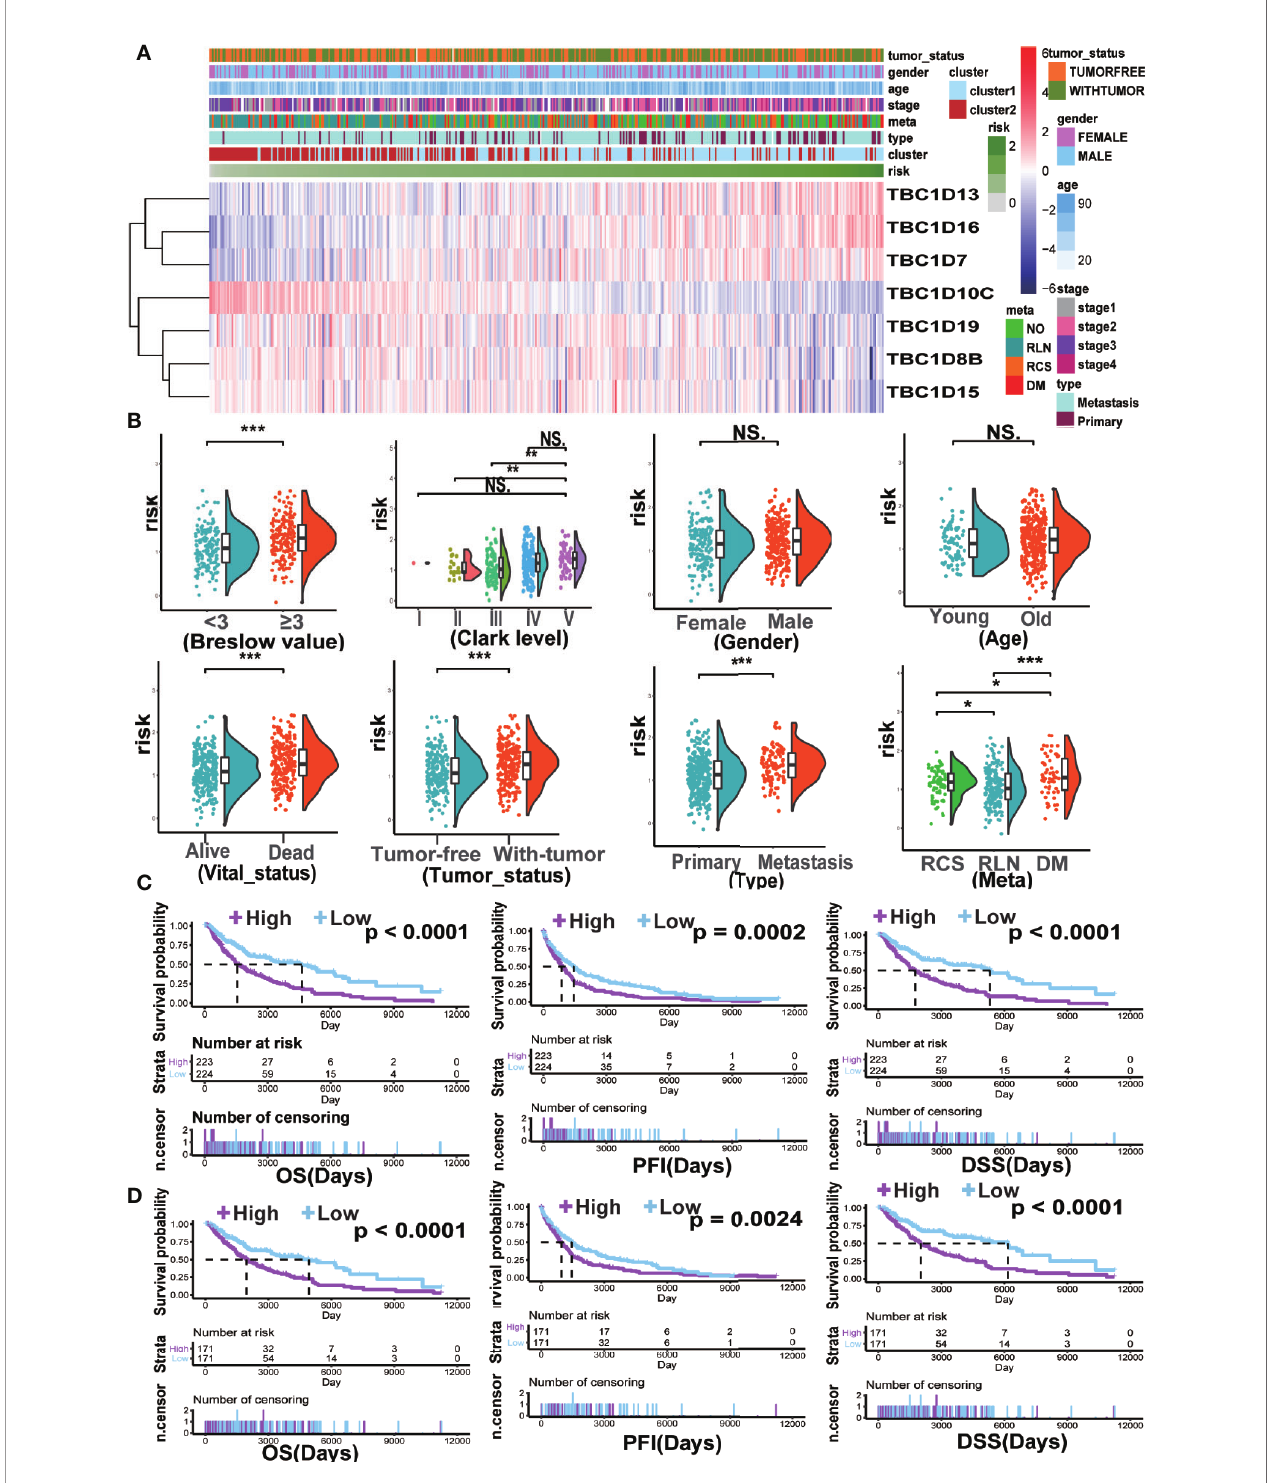
FIGURE 5 | The clinical characteristics and survival analysis based on risk score. (A) The risk score model of the seven prognostic-associated TBCs in melanoma was constructed based on the coef fi cient of LASSO. The distributions of clinical characteristics and the seven prognostic-associated TBCs expression based on the risk scores are showed with heat map. (B) The differences in risk score within various subgroups classi fi ed by clinical features including Breslow value, Clark level, Gender, Age, Vital status, Tumor status, Tumor type and Meta in the melanoma TCGA dataset. *p < 0.05, **p < 0.01, ***p < 0.001, NS. p > 0.05. Kaplan ± Meier survival analyses demonstrated the differences in OS, PFI and DSS based on risk scores (High vs Low) in tumor tissues (C) and Metastasis tissues (D) from